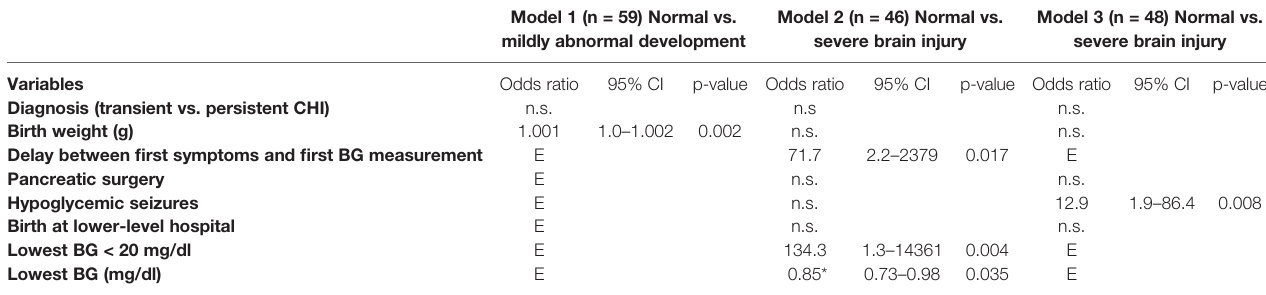
Onlysigni fi cantvariablesfromunivariateanalysiswereenteredintothemultivariatelogisticregressionmodels.Patientsbornabroadwereexcludedfromtheanalysisduetothehighrateof adverse neurodevelopment in this small subgroup. Data are presented as odds ratio for adverse neurodevelopment with 95% con fi dence interval and p-value, if signi fi cant <0.05. BG, blood glucose; CHI, congenital hyperinsulinism; OR, odds ratio; CI, con fi dence interval; n.s., not signi fi cant; E, excluded in model. Model 1: included the following risk factors: diagnosis, birth weight, percentile. Backward logistic regression was performed. Model 2: included the following risk factors: diagnosis, birth weight, delay between fi rst symptoms and fi rst BG measurement, pancreatic surgery, hypoglycemic seizures, birth at lower- level hospital, lowest BG < 20 mg/dl. Backward logistic regression was performed. *When lowest BG < 20 mg/dl is exchanged for lowest BG value in mg/dl (metric variable), the result is also signi fi cant. Model 3: included the following risk factors: diagnosis, birth weight, pancreatic surgery, hypoglycemic seizures, birth at lower-level hospital. Backward logistic regression was